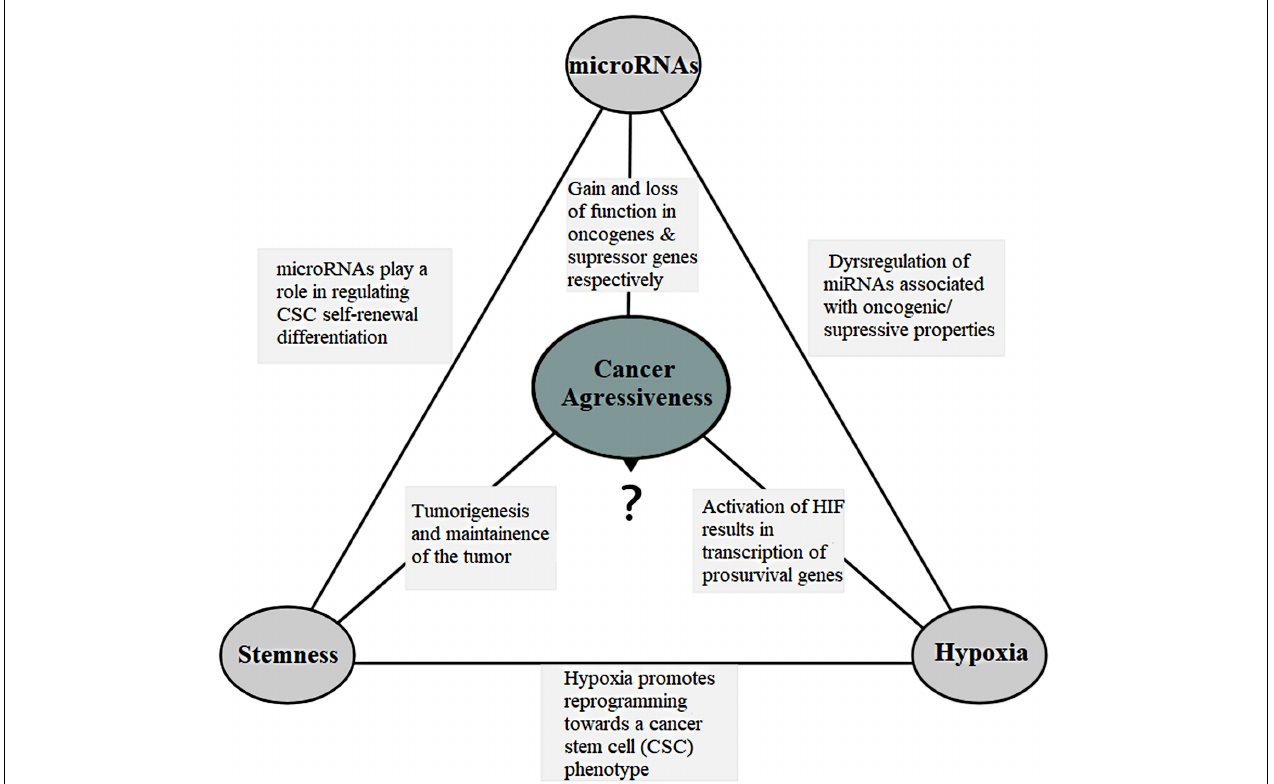
FIGURE 2 | The connection triangle. The miRNAs, hypoxia and the stem-like state all play a connected role that eventually culminates in the tumor aggressiveness. miRNAs and aggressiveness: miRNAs are often found dysregulated and have gain-of-function mutations in the miRNAs associated with the oncogenic property and loss-of-function mutations in the miRNAs with the tumor suppressor properties. miRNAs and stemness: miRNAs play a role in the regulation of cell self-renewal, differentiation and regulation of transcription factors including Nanog, SOX2 and OCT4 among others associated with the stem-like state. They also help the stem-like cells to override the G1/S checkpoint to sustain continual division. miRNAs and hypoxia: miRNAs assist forming hypoxic microenvironment and regulate the HIF switch during hypoxia. Switch of HIF-1 to HIF-2 and HIF-3 is required in order to adapt the cells to prolonged or chronic hypoxia that may otherwise lead to apoptosis. Hypoxia and aggressiveness: In intratumoral hypoxia, a phenomenon of the aggressive cancers, hypoxia inducible factor 1 α (HIF-1 α ) is stabilized, and in turn, HIF-1 results in transcription of pro-survival target genes involved with tumor angiogenesis, invasion, cell survival, EMT, and metabolism among others. Hypoxic pseudopalisading zones are protected from chemoradiation because of vascular stasis and depletion of molecular oxygen cells contributing to aggressiveness. Hypoxia and miRNAs: under hypoxia, a group of miRNAs, hypoxia regulated miRNAs-HRMs, are deregulated modulating processes involved in tumor survival. Hypoxia and stemness: Hypoxia promotes reprogramming towards a cancer stem-like cell (CSC) phenotype and expansion of CSC populations, a population thought to be responsible for the maintenance and recurrence of the tumor. It is in the hypoxic regions also that the CSCs go into quiescence to escape